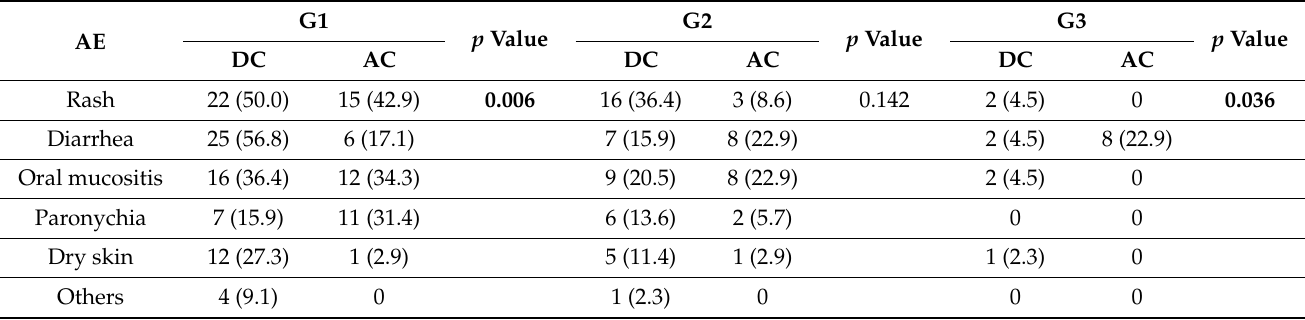
Table 3. Treatment-emergent AEs in the pooled cohort of the DC and the AC (N = 79).